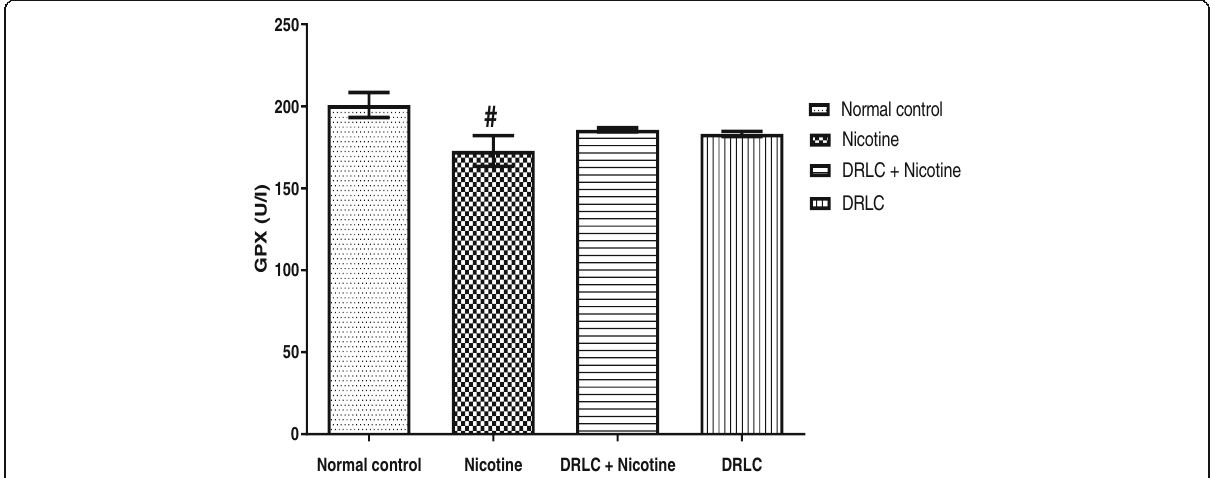
Fig. 4 Charts showing GPX levels in experimental animals. Values are mean ± SEM; N = 5. # Statistically different from normal control group ( p < 0.05)